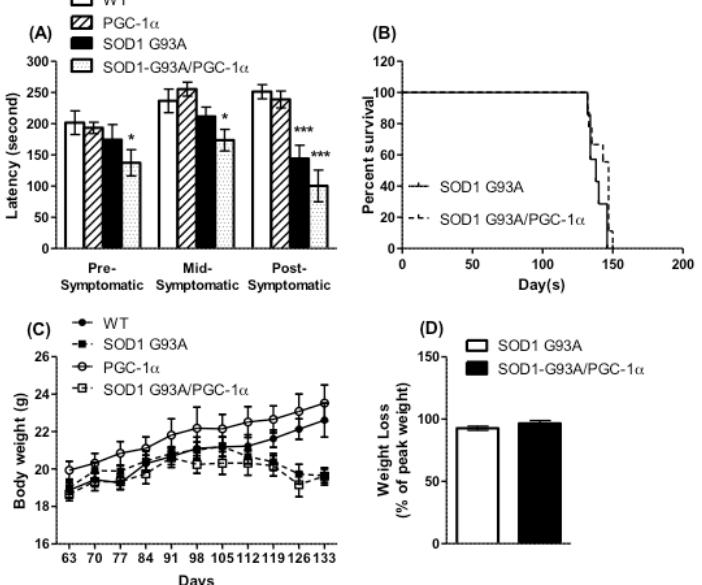
Figure 3. Motor function, survival, and body weight were not improved by actin-PGC- 1α expression. ( A ) Motor function was assessed by the accelerating rotarod test. The double-transgenic SOD1 G93A /actin-PGC- 1α mice performed worse than the WT in pre-symptomatic (week 10), mid- symptomatic (week 14), and post-symptomatic (week 17) stages. Data are mean ± SEM from n = 10 WT and 11 SOD1 G93A mice. * p ≤ 0.05, *** p ≤ 0.001 as compared to WT by two -tailed S tudents’ t -test. ( B ) Survival was not changed in the SOD1 G93A mice by expression of actin-PGC- 1α. ( C , D ) The loss